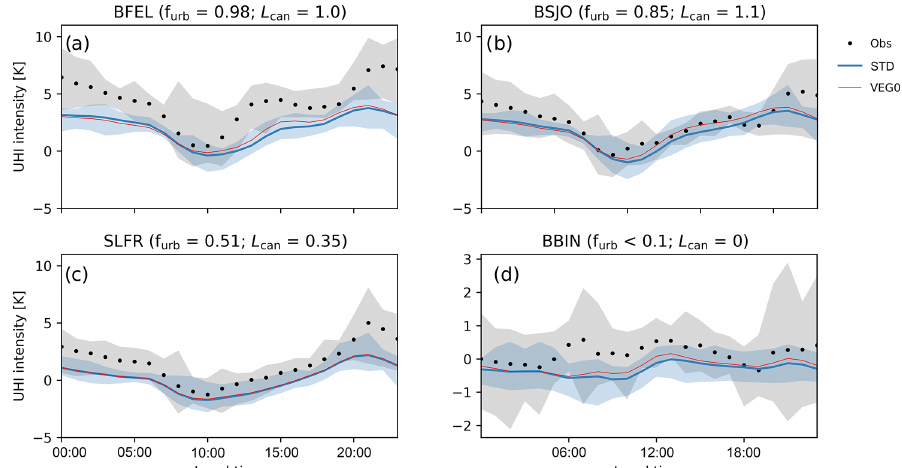
Figure 7. Comparison between period-averaged daily profiles of observed (Obs) and model-simulated 2m UHI intensity at the BFEL, BSJO, SLFR and BBIN sites during the evaluation period. The BLER site is used as a rural reference. Black dots indicate the observations. Blue lines and red lines indicate the results from the STD and LA0 model runs, respectively. The range of variability within the selected period is shown as a shaded area (only for Obs and